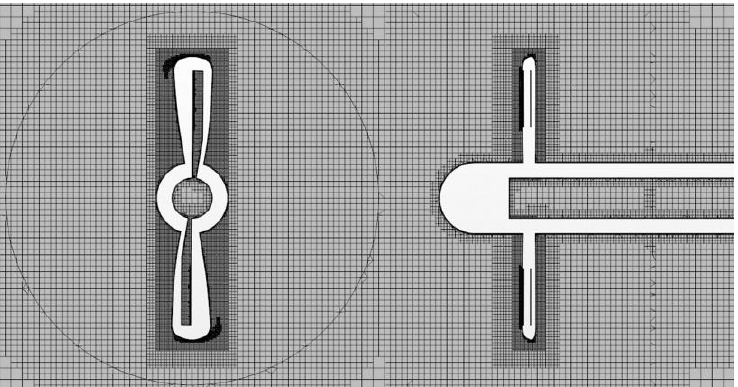
Figure 5. Grid system for numerical simulations.